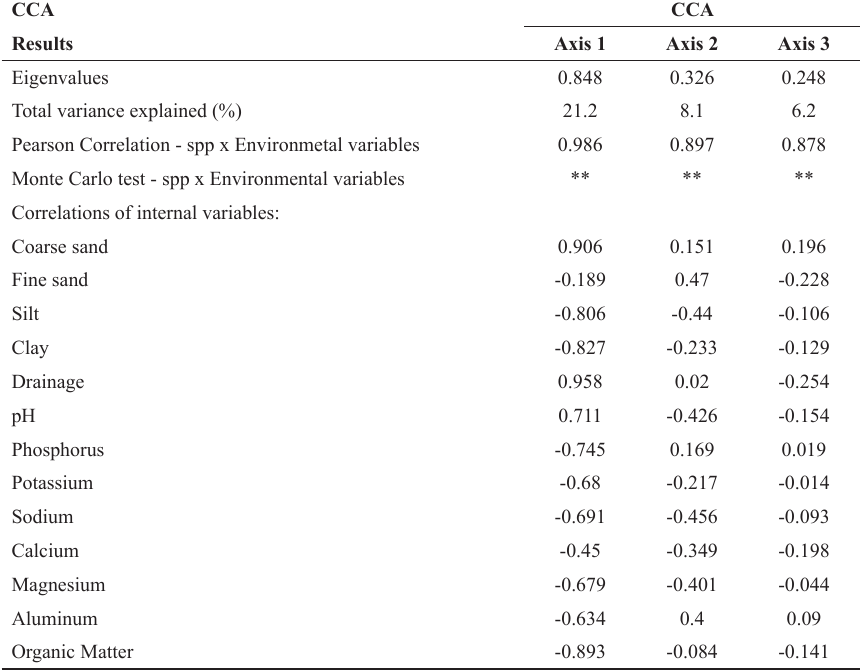
Results of the Canonical Correspondence Analysis (CCA) with 64 species in Jacarenema Natural Municipal Park, Vila Velha,